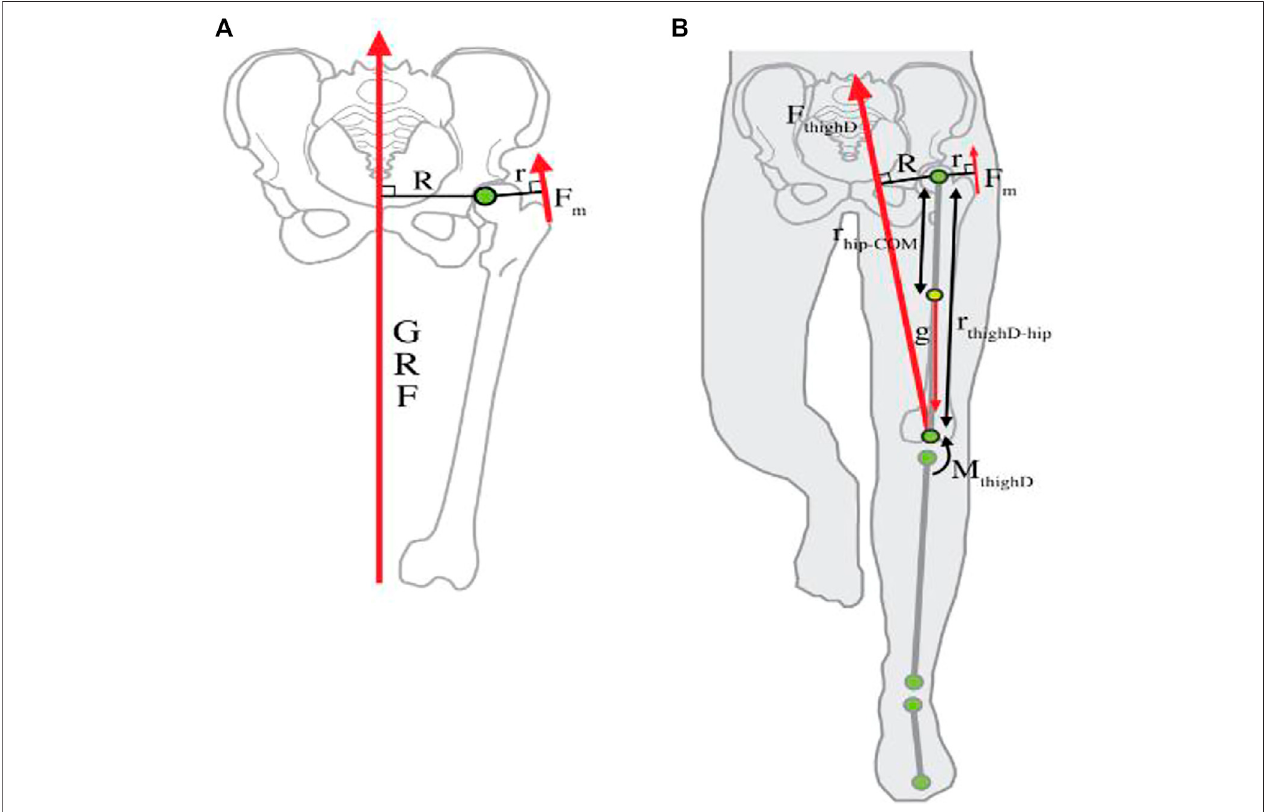
FIGURE 1 | Hip abductor force production. (A) Typical stationary biomechanical model. (B) Inverse dynamics models the lower extremity (Warrener et al., 2015).